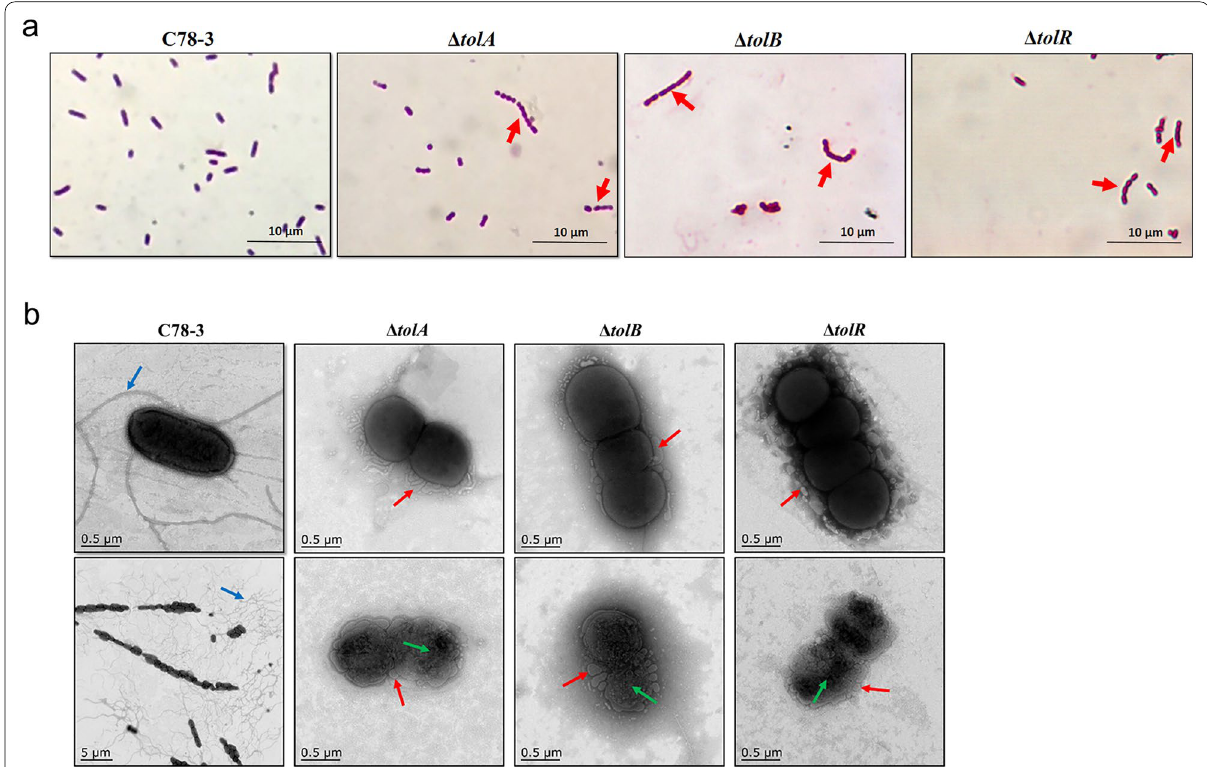
Fig. 2 Morphological characterization of S. Choleraesuis C78-3 and three mutants. a Gram staining of C78-3 and three mutants grown in LB were examined by light microscopy ( 1000). The Δ tolA , Δ tolB , and Δ tolR strains grew in chains of coccobacilli (red arrow). b Morphology characteristics of × C78-3 and three mutants were evaluated by TEM. C78-3 was rod-shaped and presented long flagella (blue arrow). The Δ tolA , Δ tolB , and Δ tolR strains showed an altered morphology with long chains and formed vesicles at the cell surface (red arrow), while some mutants were severely damaged in their cell morphology (green arrow)